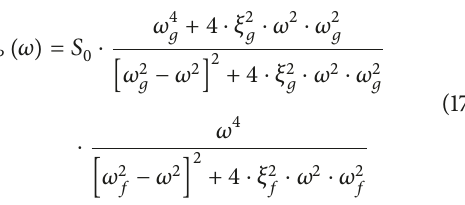
(N-S direction) of Figure 2. In the same figure, the four fixed base external braced frames, connected at the floor level to the building by means of FVDs, are illustrated. The rocking braced towers are placed in the same location of the fixed-based frames and also have the same geometrical and mechanical